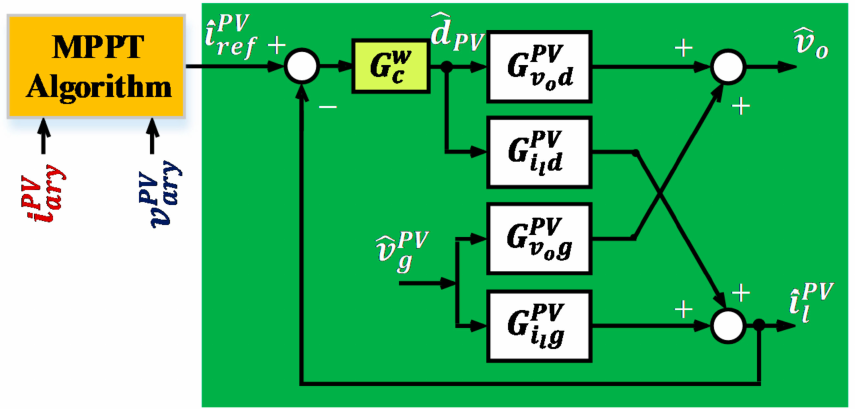
Figure 8. Model of a current programmed boost converter with